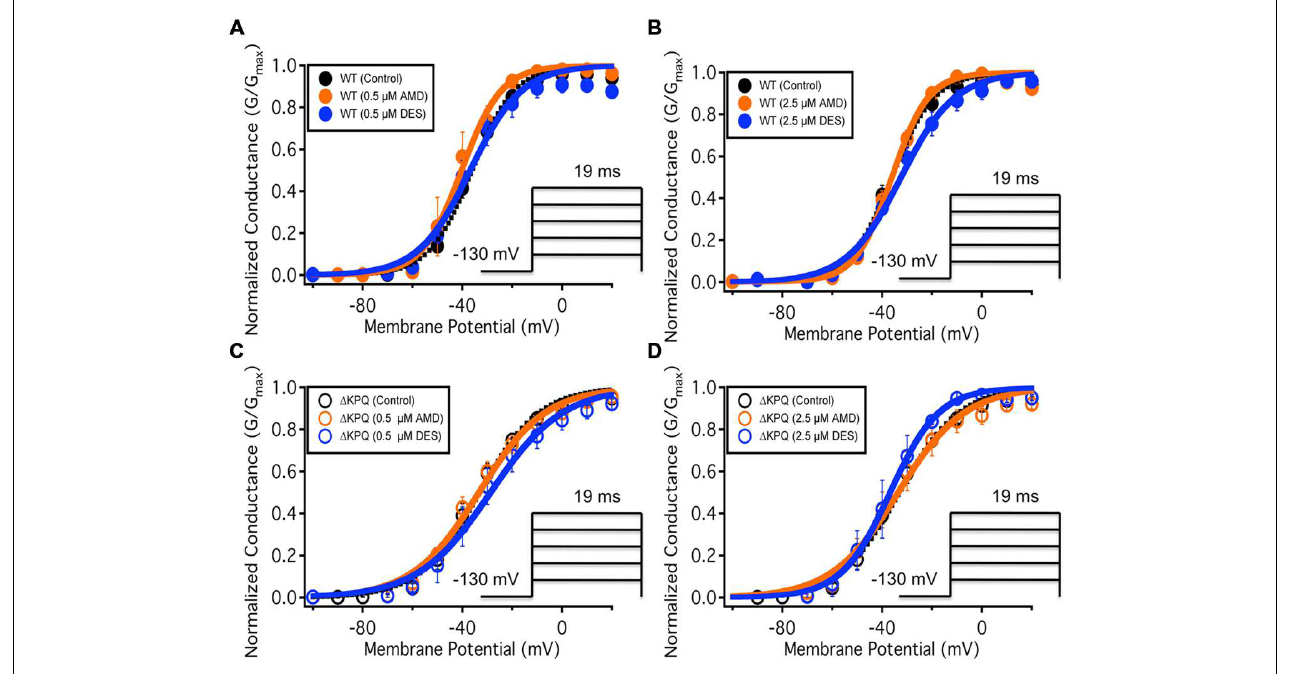
FIGURE 1 | (A–D) Show the voltage dependence of activation as normalized conductance plotted against membrane potential. The black curves represent the WT Na v 1.5 or (cid:49) KPQ conductance with no drug perfusion, the orange curves represent Na v 1.5 or (cid:49) KPQ conductance after either 0.5 or 2.5 µ M AMD perfusion, and the blue curves represent Na v 1.5 or (cid:49) KPQ conductance after either 0.5 or 2.5 µ M DES perfusion.